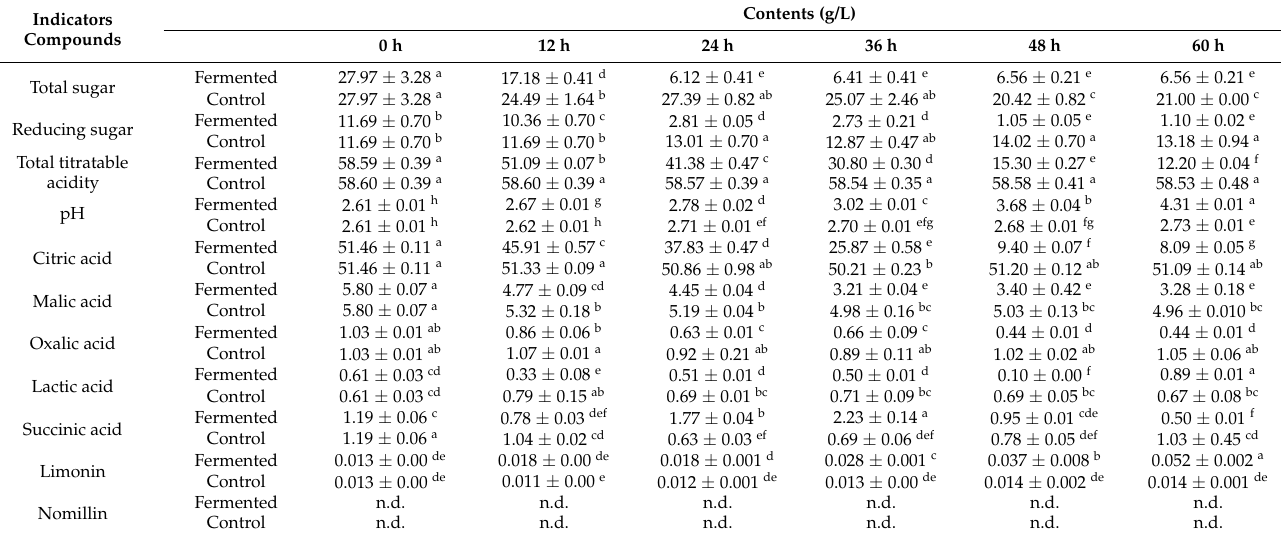
Table 1. Physicochemical properties and organic acids of fermented and control lemon